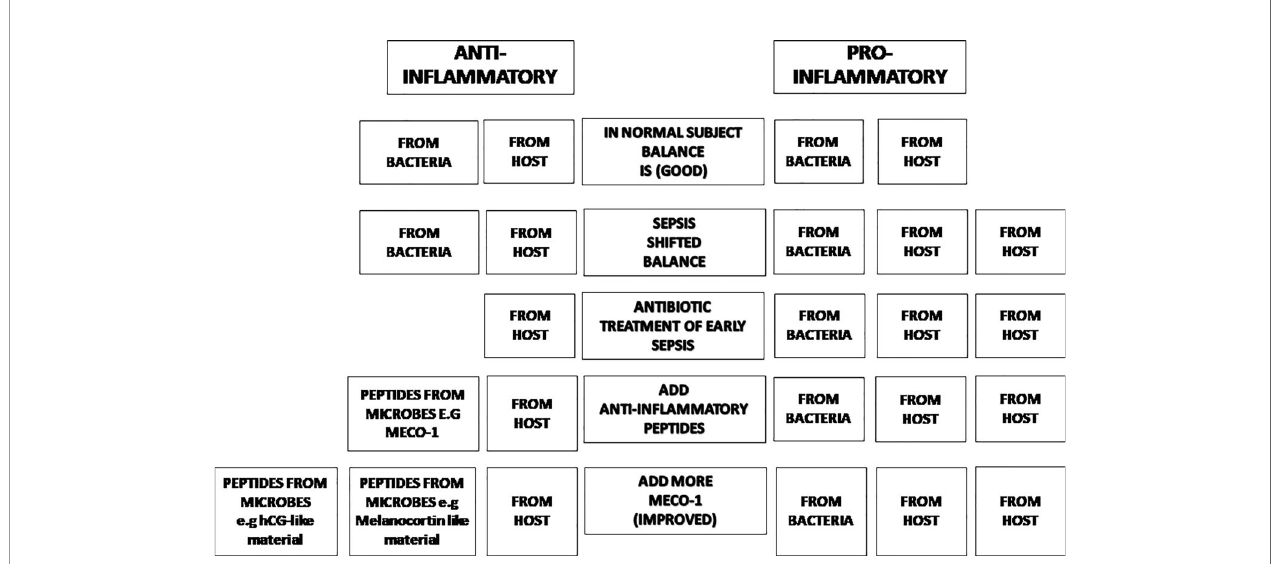
FIGURE 1 | The balance of in fl ammatory status. In normal subjects, the in fl ammatory status is balanced (Line 1). Once there is in fl ammation in the subject, the balance will shift in favor of pro-in fl ammatory effectors (Line 2). Antibiotic treatment moves the trend to more pro-in fl ammatory status due to its bactericidal effect (losing anti-in fl ammatory agents from microbes) (Line 3). Anti-in fl ammatory peptides from microbes (such as MECO-1 or hCG-like material) will help restore the balance (Line 4 & Line